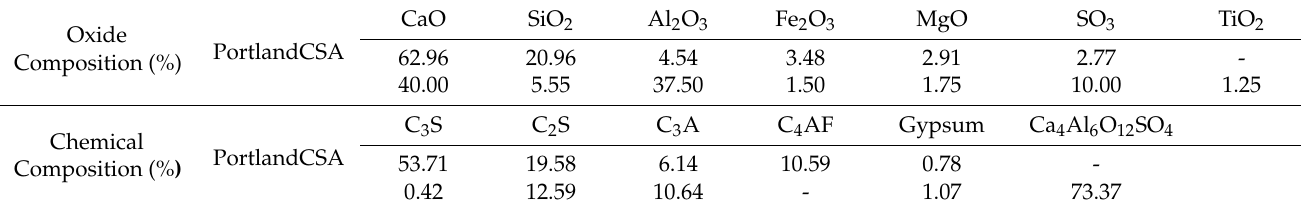
Table 5. Oxide and chemical compositions of cement (%).